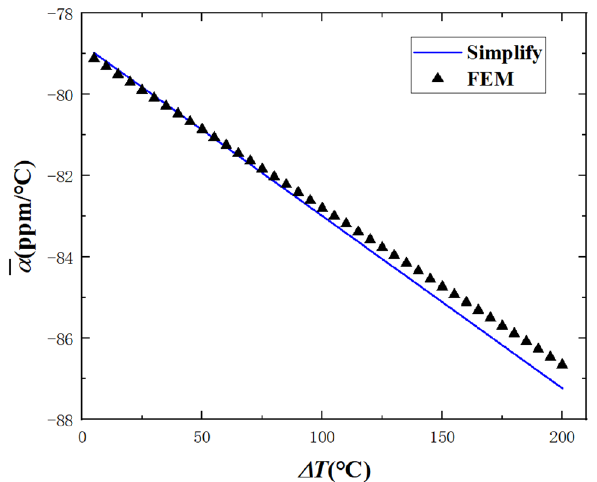
Figure 8. Comparison between theoretical formula and finite element method of nonlinear CTE.